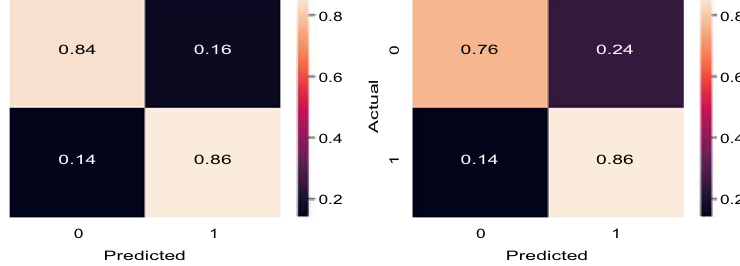
Figure 8. Dataset 1: Confusion matrices for the best results of AutoThorax -Net (left) and CheXNet